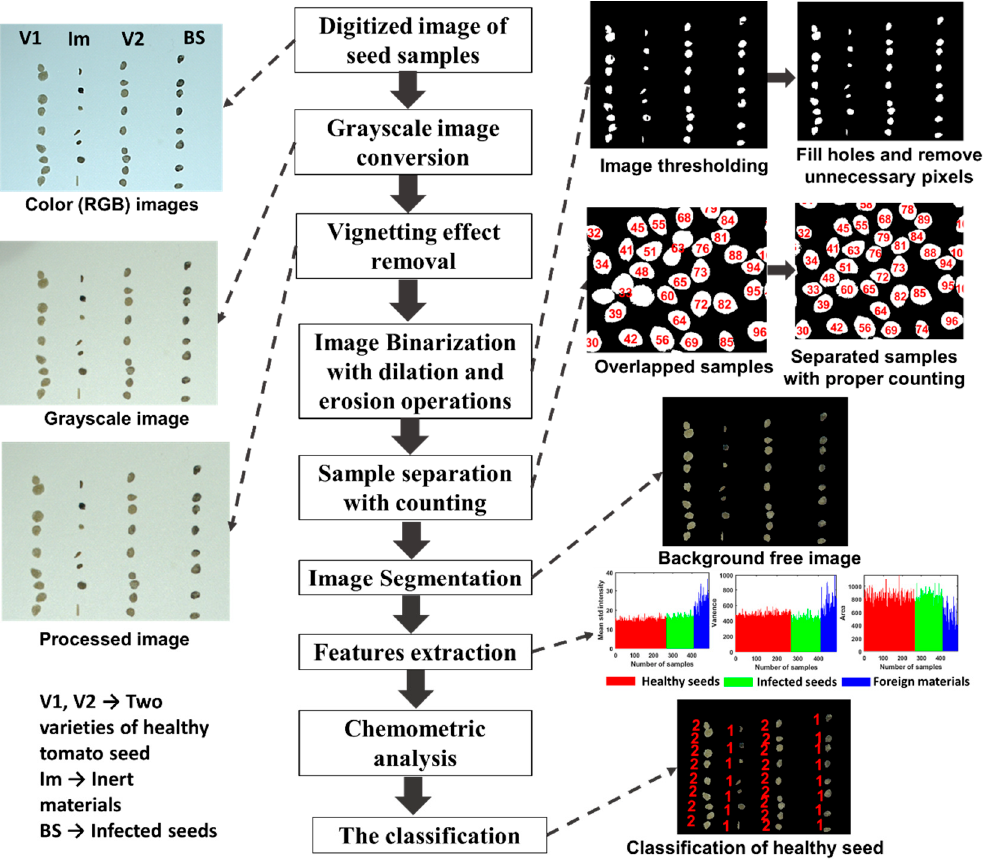
Figure 3. The phases of the proposed approach.